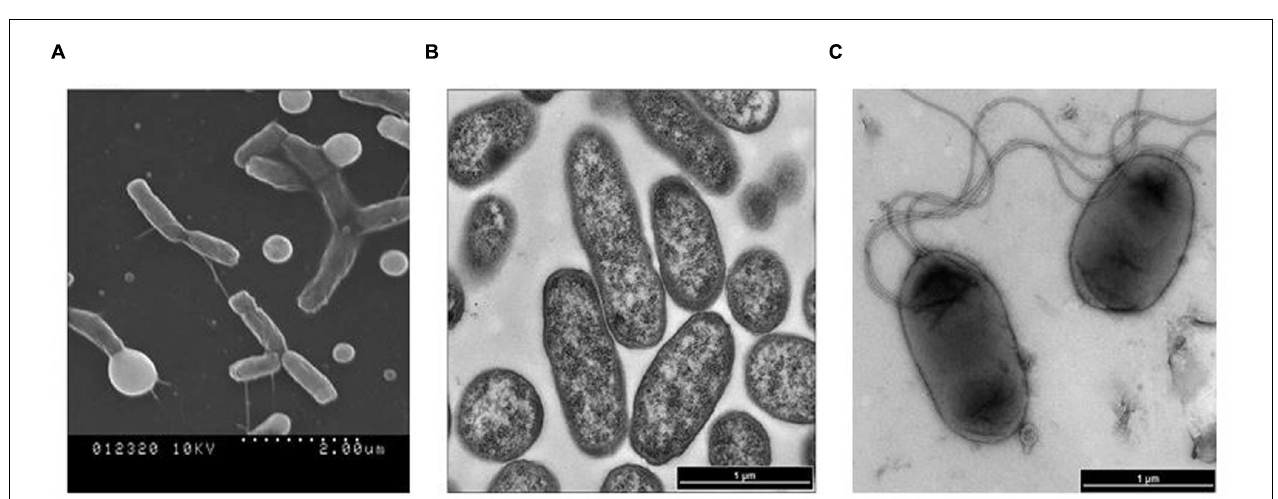
FIGURE 3 | Scanning electron microscopy (SEM) imaging of Devosia mutans 17-2-E-8 (A) and transmission electron microscopy (TEM) images (B,C) of isolate 17-2-E-8.